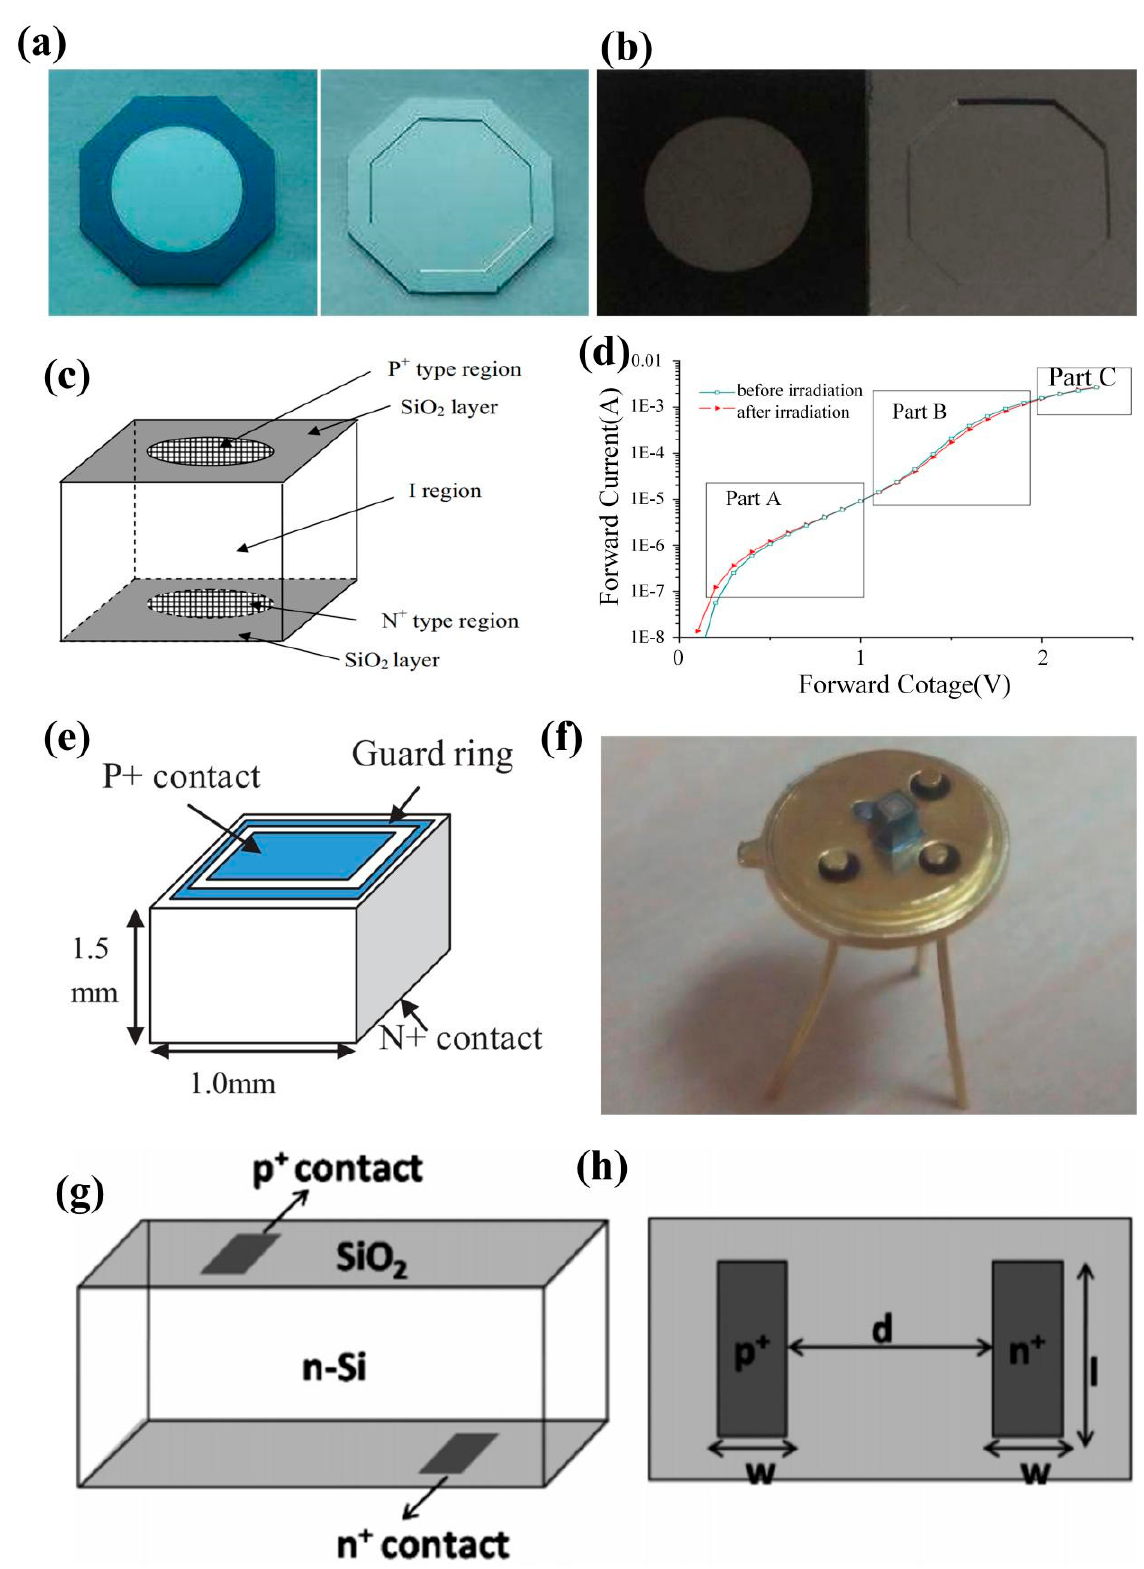
Figure 1. ( a , b ) Picture of thin PIN detector [13,14]; ( c ) structural diagram of 1.5 mm-thick silicon PIN radiation detector [15]; ( d ) IV characteristic change of 1.5 mm-thick silicon PIN radiation detector [15]; ( e ) structural diagram of 1.5 mm-thick silicon PIN detector based on guard ring [16]; ( f ) photos after the detector is packaged [16] ( g , h ) bilateral PIN diode structure [17].